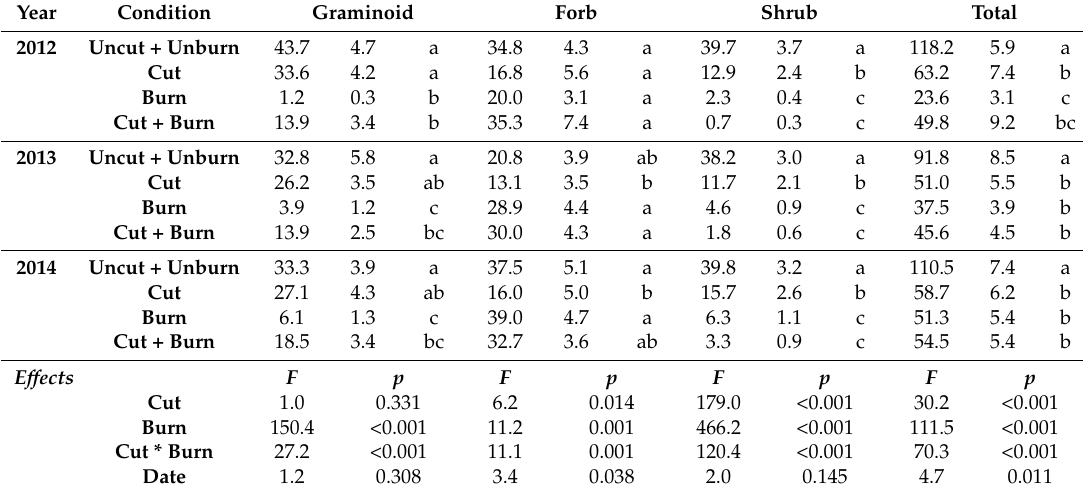
Table 2. Understory plant cover (%) after salvage logging and wildfire in bark beetle-infested lodgepole pine forests. Data are means with standard error for twelve stand-scale sampling areas per ecosystem condition per year. The sum of plant growth forms may exceed 100% within treatment due to overlapping plant canopy layers. Different letters within columns denote differences within single years based on Tukey’s pairwise adjusted